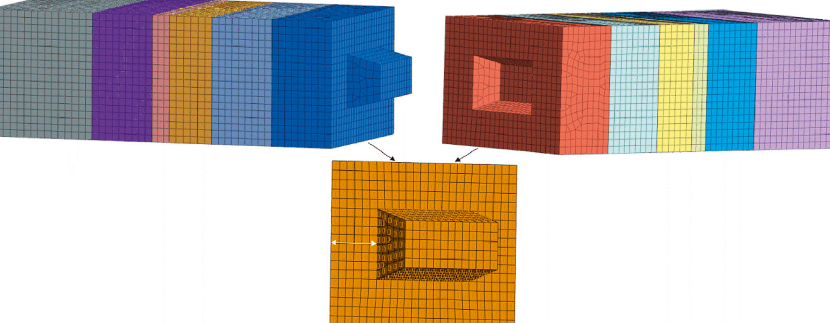
Figure 5: Three-dimensional sketch of the indentation of a mortise and tenon joint.